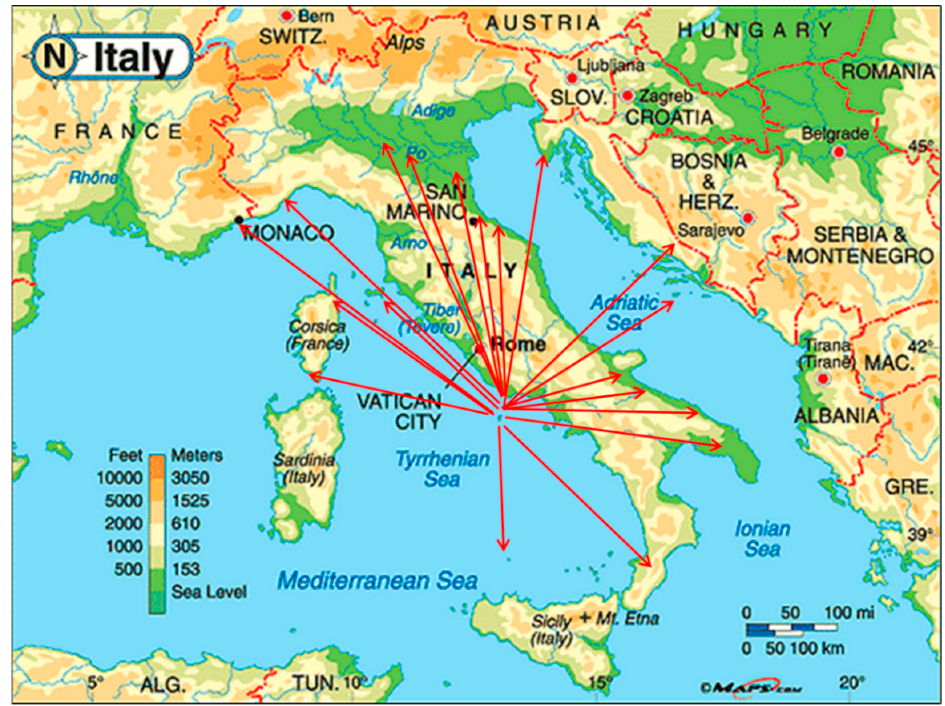
Figure 12. Map with directions to archaeological sites with Palmarola obsidian artifact attributions, including across the Adriatic.